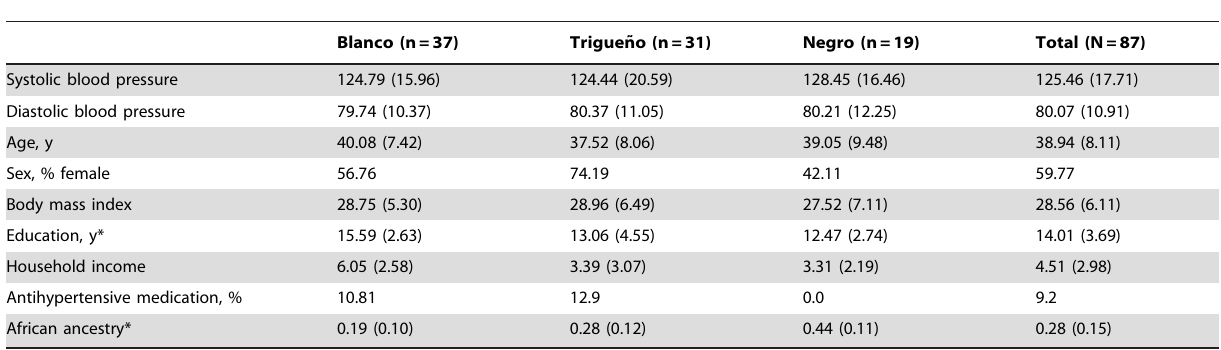
Table 1. Descriptive statistics for study